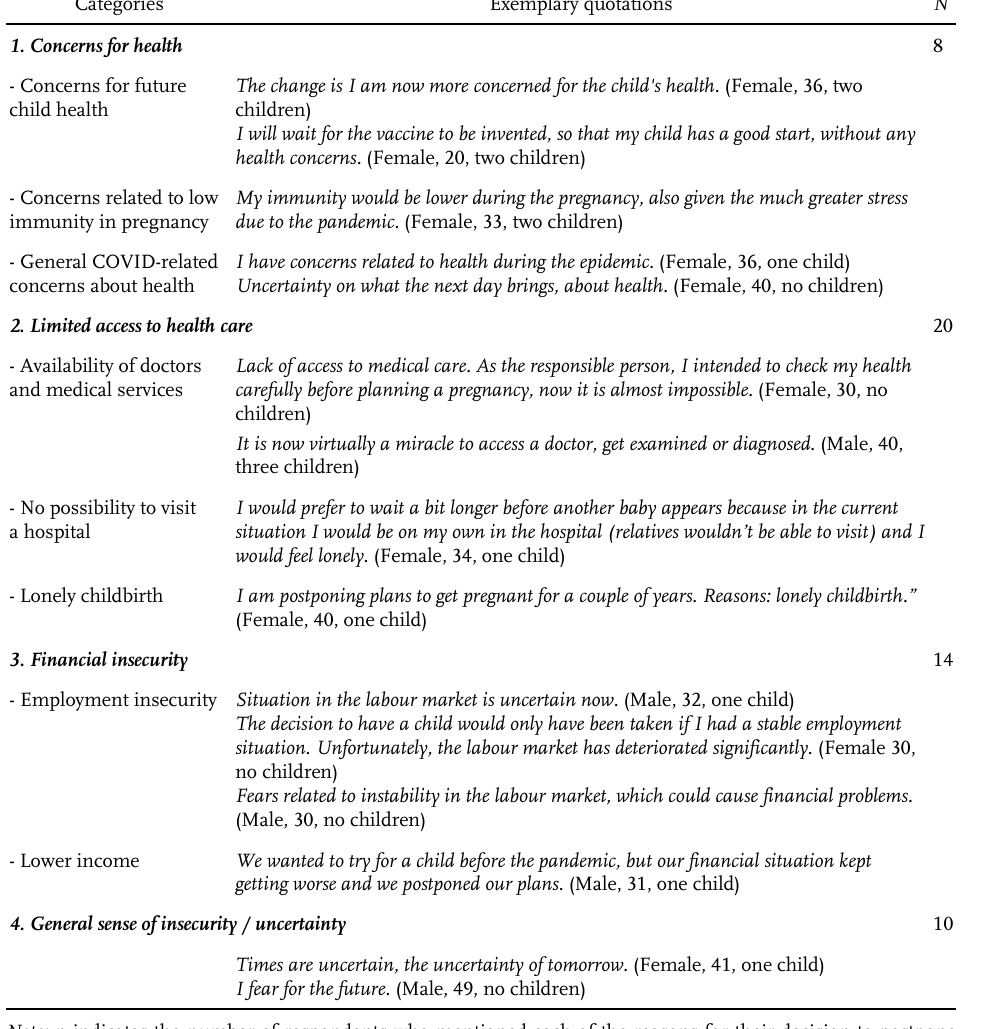
Table 5 : Responses to an open question on the effect of the COVID-19 pandemic on childbearing plans among the respondents who had intended to have a child before the outbreak of the pandemic. Coding categories and exemplary quotations (n=48) Categories Exemplary